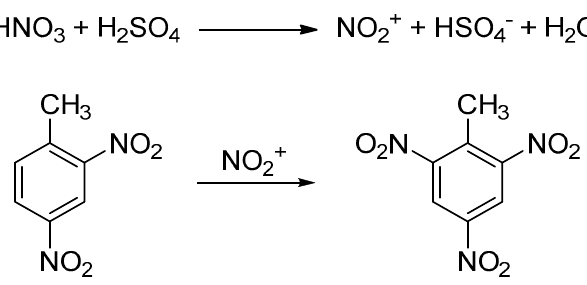
Figure 1. Synthetic path for the conversion of 2,4-dinitrotoluene (2,4-DNT) to 2,4,6-trinitrotoluene Figure1. Syntheticpath forthe conversionof 2,4-dinitrotoluene (2,4-DNT)to 2,4,6-trinitrotoluene (TNT).